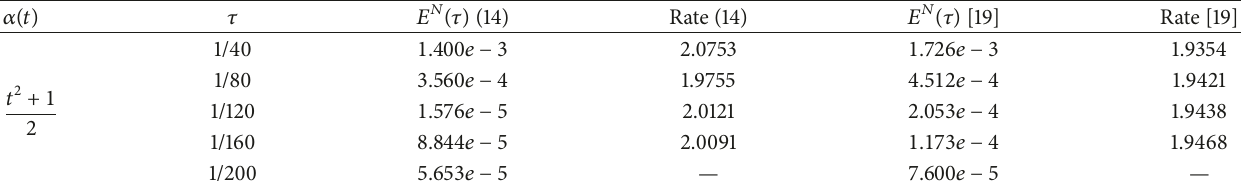
Table 1: Maximum errors and convergence rates for Example 1 at 𝑇 = 1 and 𝜎 = 1 − 𝛼 1 /2 .